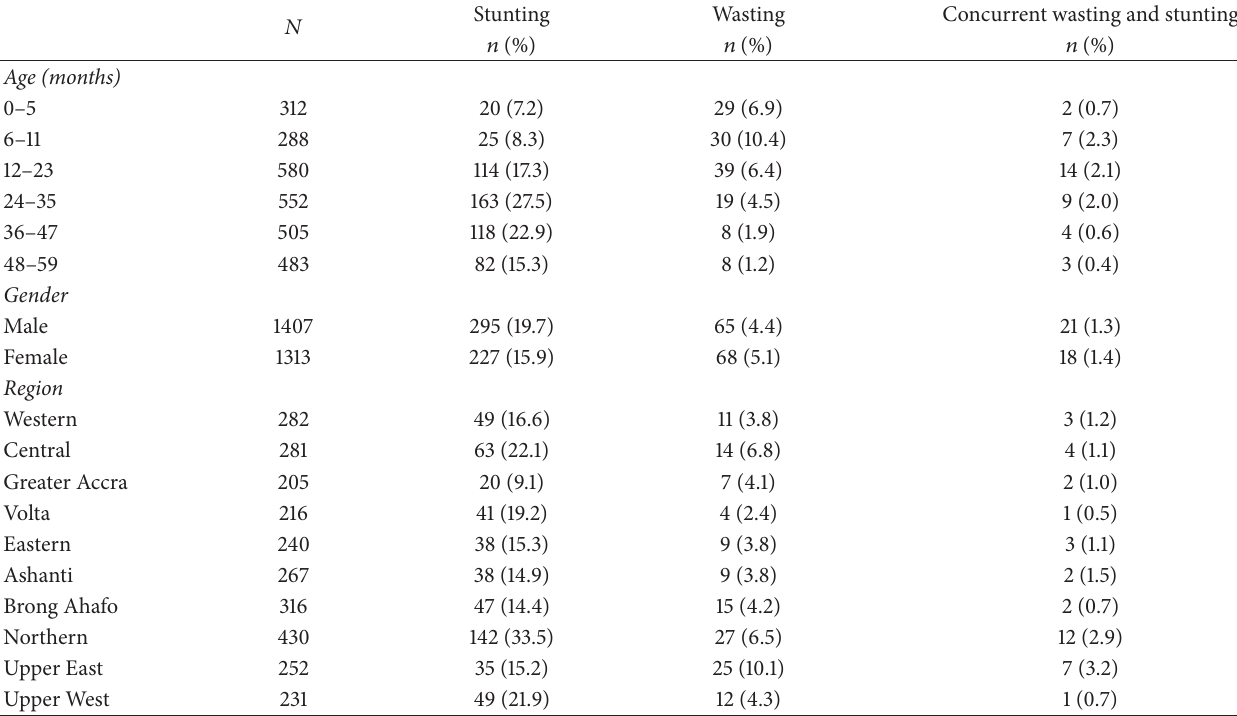
Table 3: Prevalence of undernutrition according to age, gender, and geographical location (weighted analysis). 𝑁 Stunting